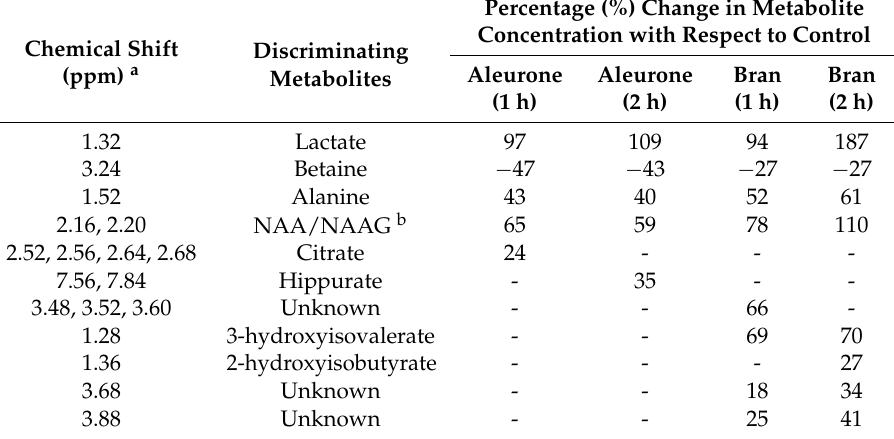
Table 3. Discriminating metabolites (with respect to control) at one hour and two hours postprandial following aleurone and